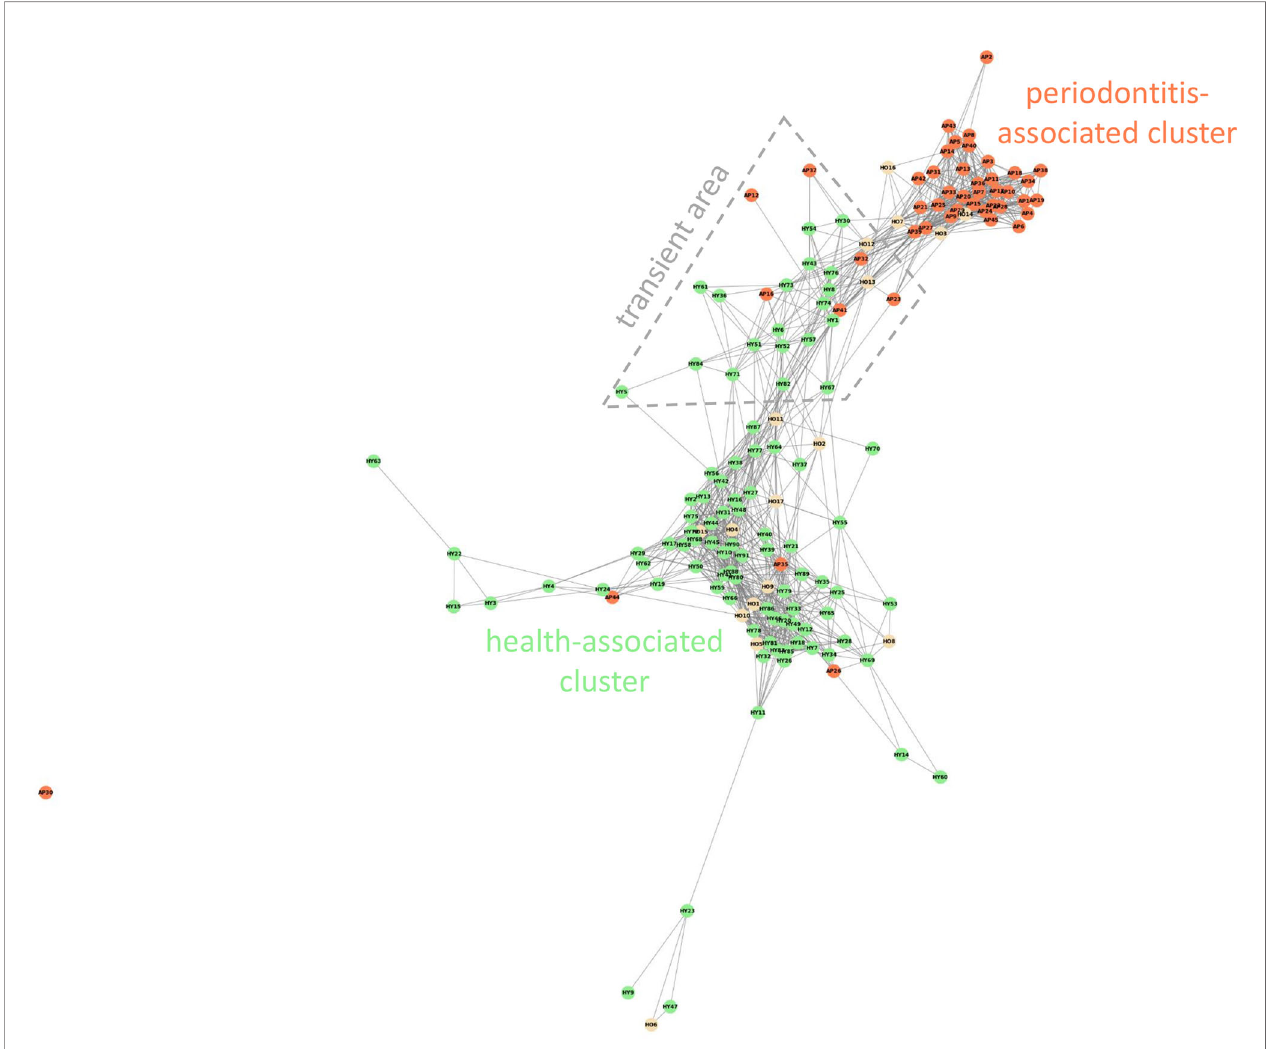
FIGURE 1 | Weighted Jaccard Similarity clustering analysis of all OM samples. Weighted Jaccard similarity index 0.3. The red-colored spots correspond to patients with AP, HY samples are green and HO samples are yellow. The transient area is delimited with the gray dashed